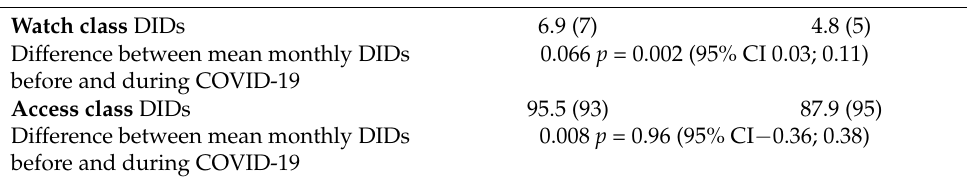
before and during